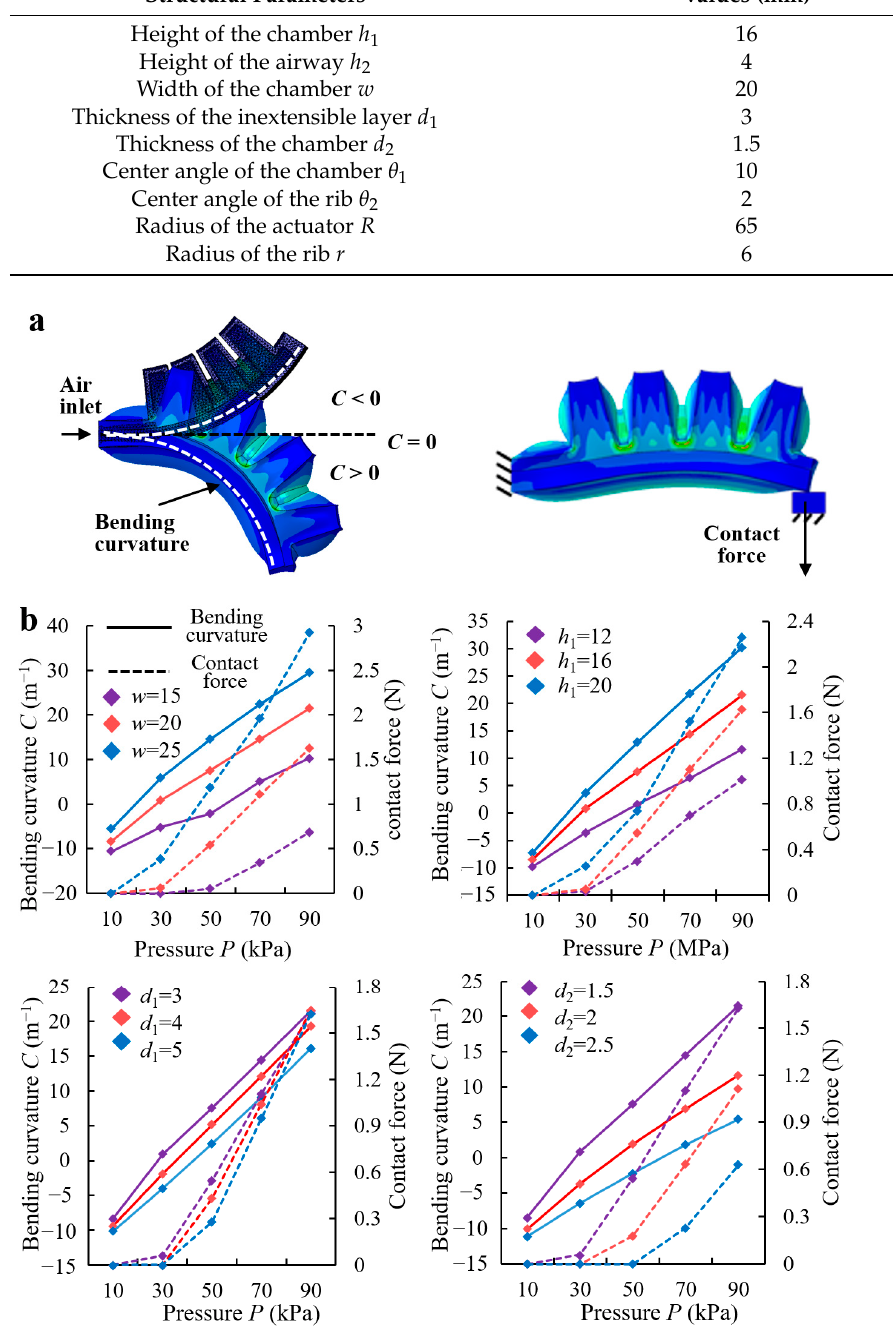
Figure 2. ( a ) Finite element models of the elastic actuator’s bending deformation and contact force under pressure drive. ( b ) Simulation results of the effects of width of the chamber w , height of the chamber h 1 , thickness of the inextensible layer d 1 , and thickness of the chamber d 2 on the bi-directional bending curvature and contact force of the elastic actuator under pressure